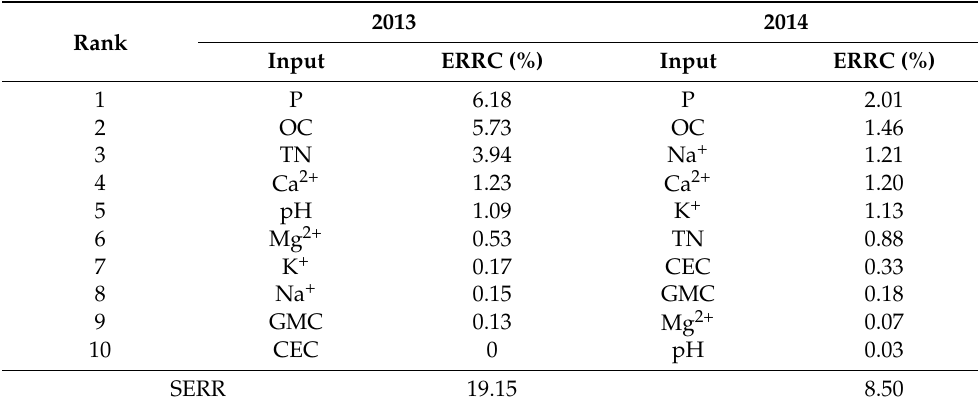
Table 6. Calculated individual contribution (ERRC) of each soil property and the sum of contribution (SERR) to crop yield in the 2013 and 2014 cropping seasons, obtained with the non-linear finite impulse response (NFIR) model, accounting for a linear relationship only